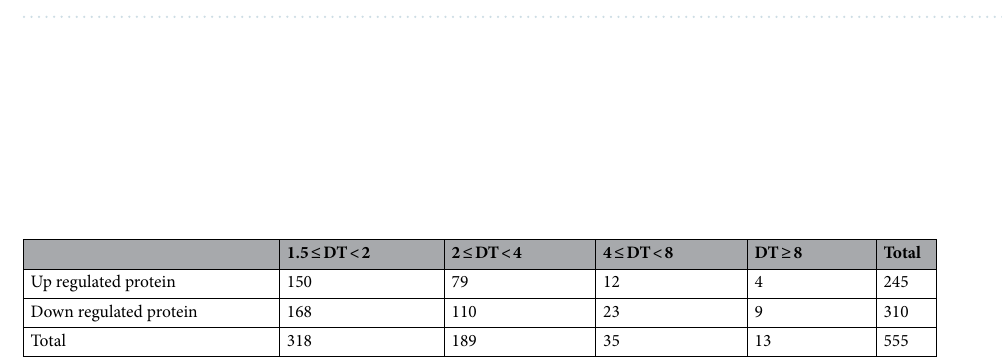
Figure 2. SDS-PAGE electrophorogram of root protein of flue-cured tobacco at seedling under two potassium treatment.